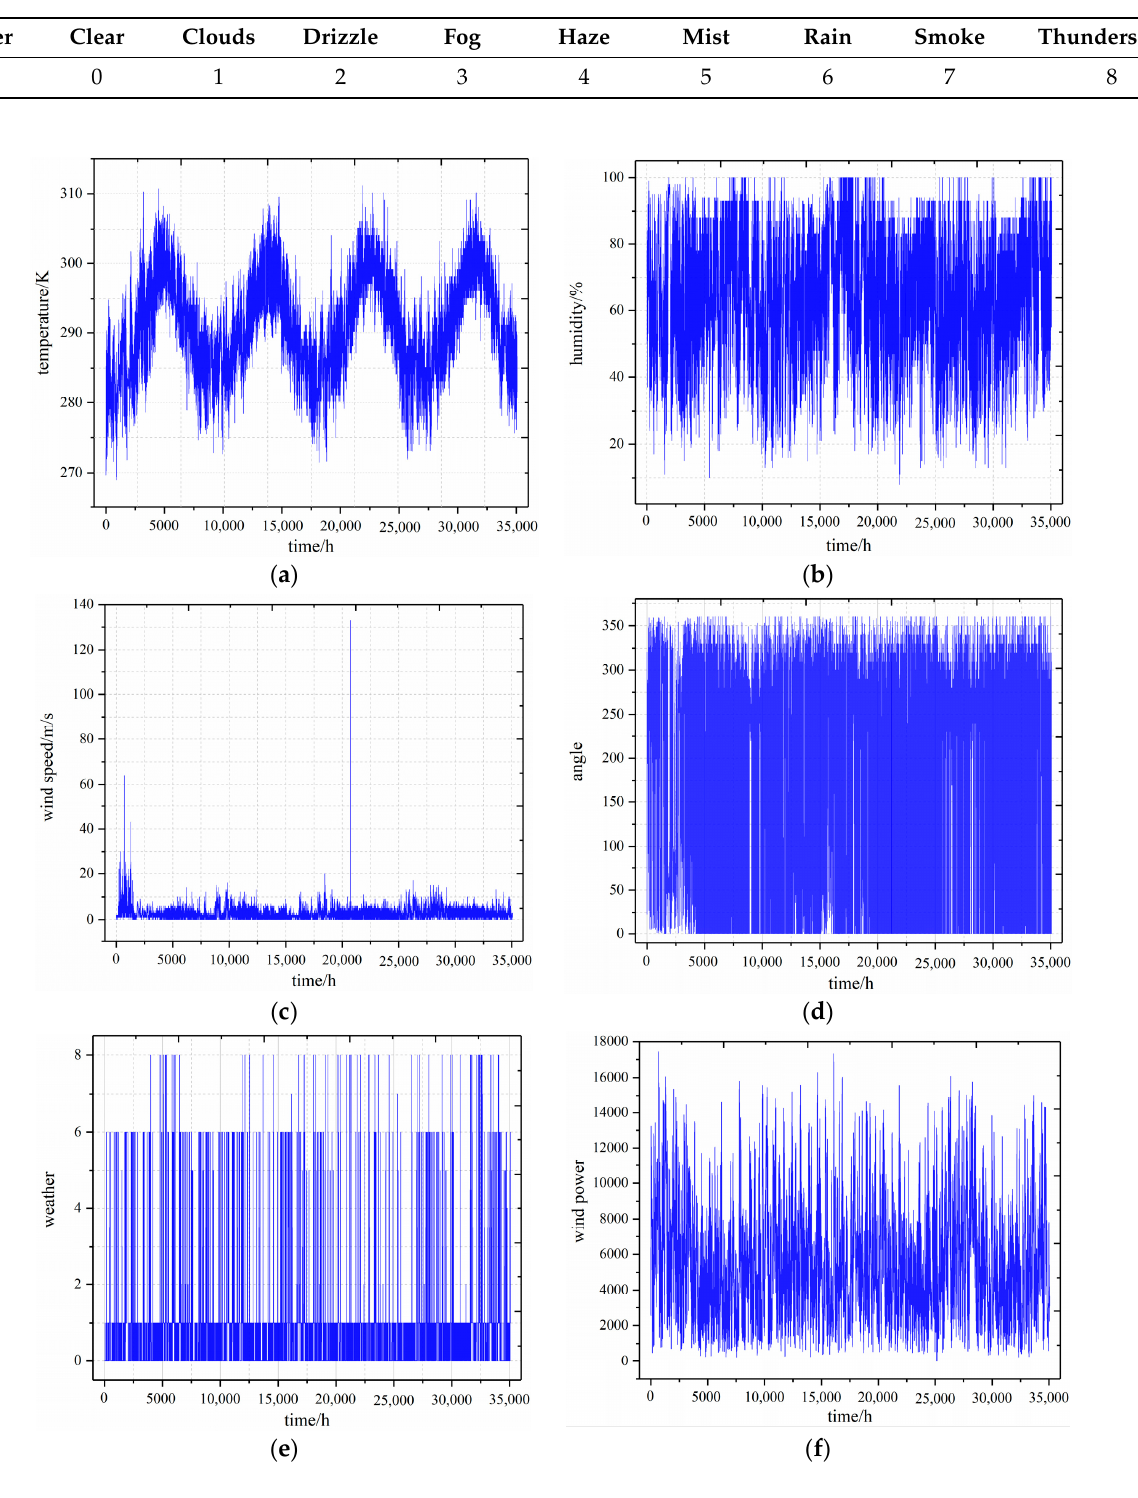
Figure 4. The initial data curves: ( a ) temperature data curve; ( b ) humidity data curve; ( c ) wind speed data curve; ( d ) angle data curve; ( e ) weather data curve; and ( f ) wind power data curve.